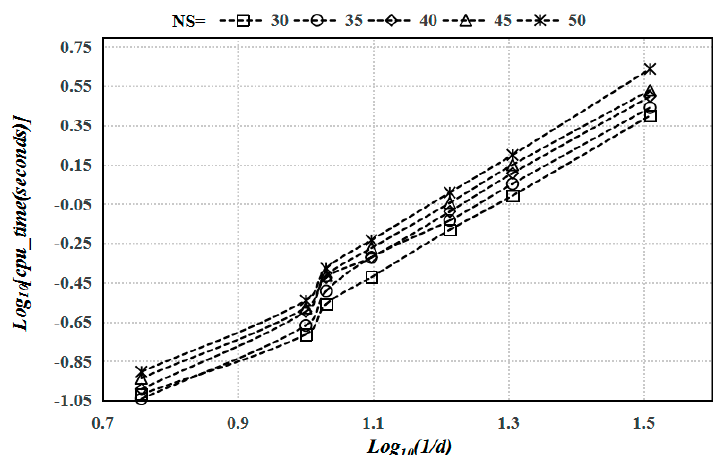
Figure 7. The computational time (CPU-time) for solving the bending deflection of a CCCC FG plate ( n = 1) subjected to a uniform load using the present method, with different values of nodes of star in a local domain.